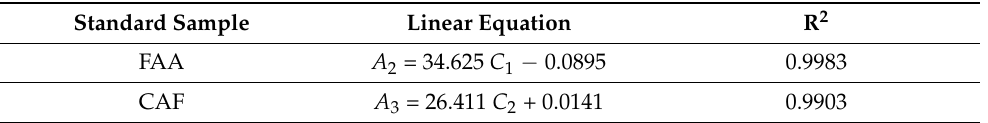
Table 1. Standard curve of FAA and CAF.